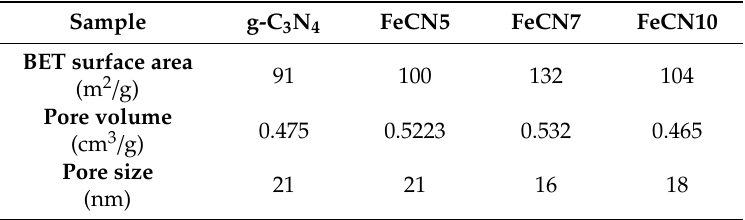
Figure 5. ( a ) N 2 adsorption-desorption isotherms of Fe-doped g-C 3 N 4 nanosheets with di ff erent Fe concentrations and ( b ) Barrett-Joyner-Halenda (BJH) pore size distribution plots. Table 1. The Data of Brunauer–Emmett–Teller (BET) Surface Area, Pore Volume and Pore Size of Fe-Doped g-C 3 N 4 Nanosheets with Di ff erent Fe Concentrations.